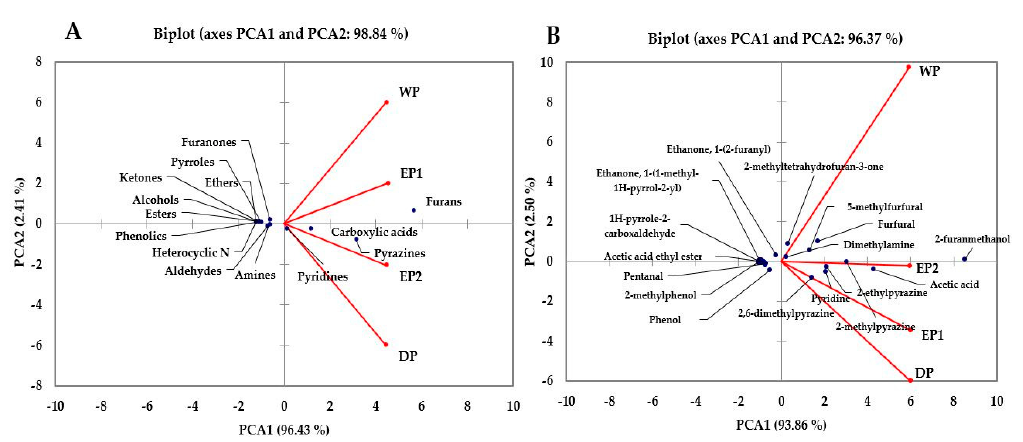
Figure 9. Biplot of the principal component analysis of the volatile classes ( A ) and individual compounds ( B ) of coffee obtained using different processing methods. EP1: elephant dung coffee (pulp was completely digested); EP2: elephant dung coffee (pulp was not digested); WP: wet-processed coffee beans; DP: dry-processed coffee beans.